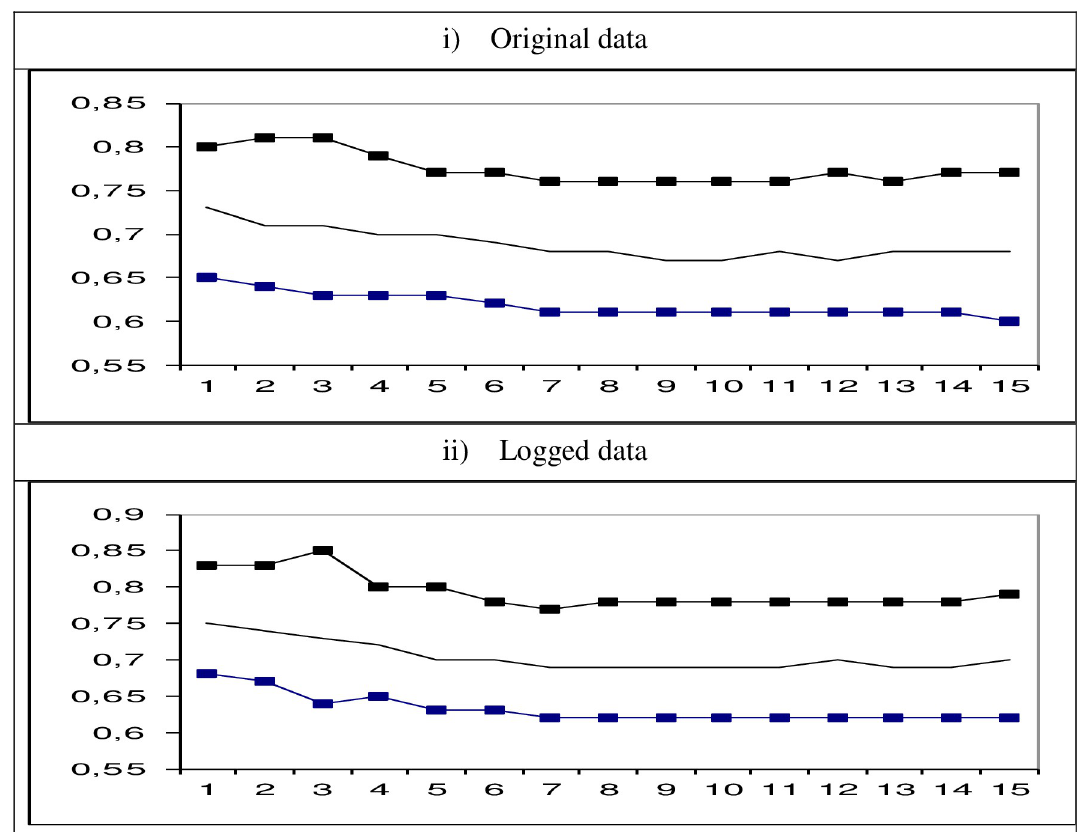
Fig 3. Estimates of d adding successively one observation since February